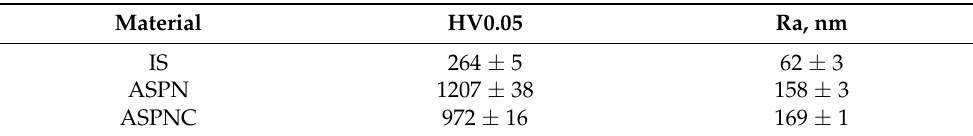
Table 2. Surface hardness (HV) and roughness (Ra) of AISI 316L steel in its initial state (IS) and following ASPN and